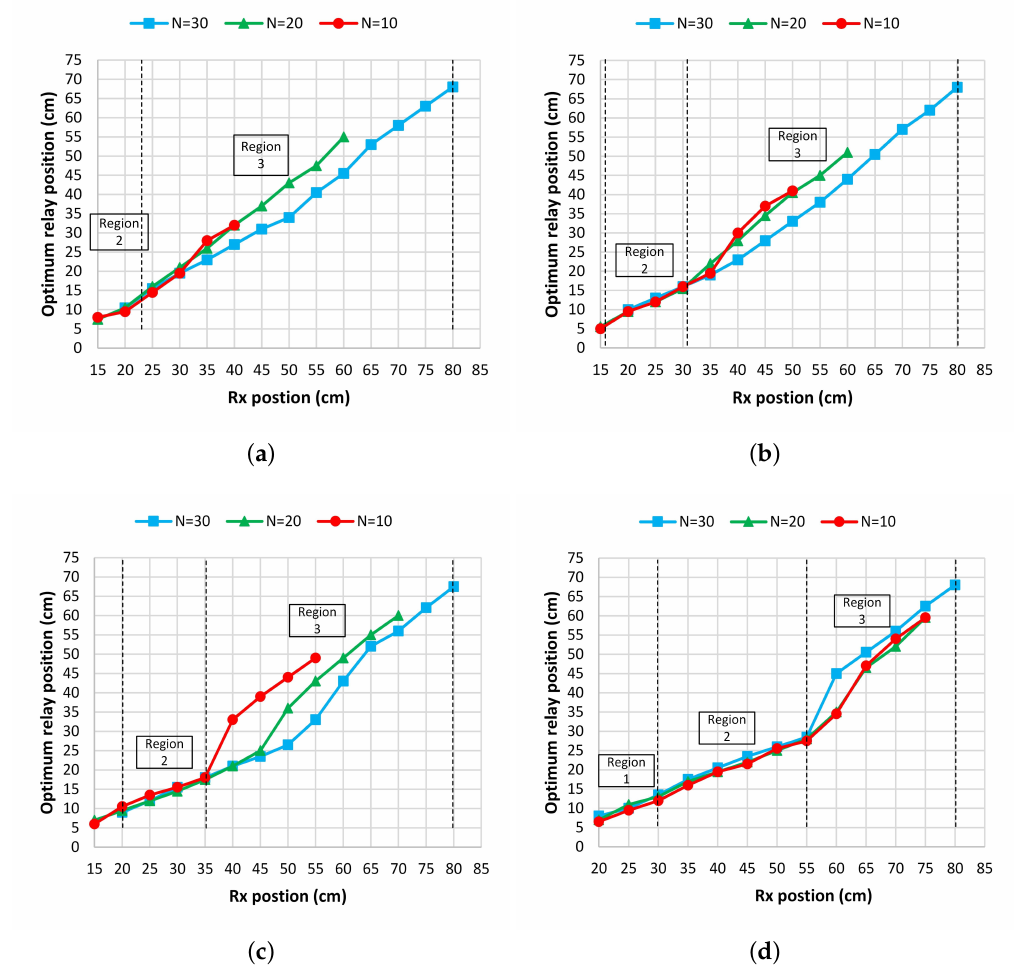
Figure 6. Optimal relay position vs. receiver position under different number of turns